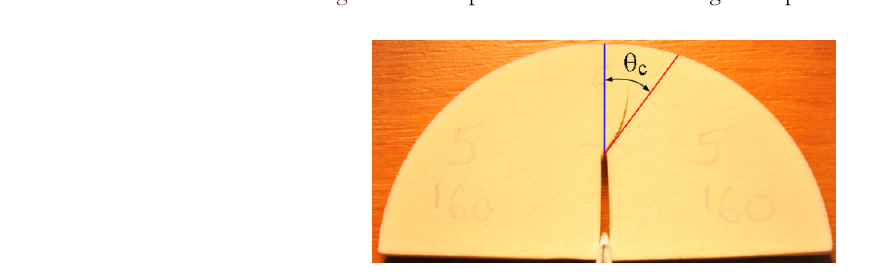
Figure 5 : Crack paths resulted from testing SEC specimens.